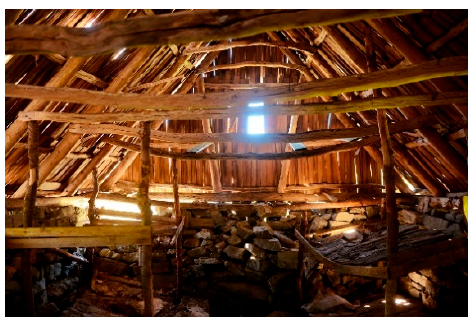
Figure 32. Interior of the glada, Carine, katun of Popovi ć i, photo: I. Lakovi ć .